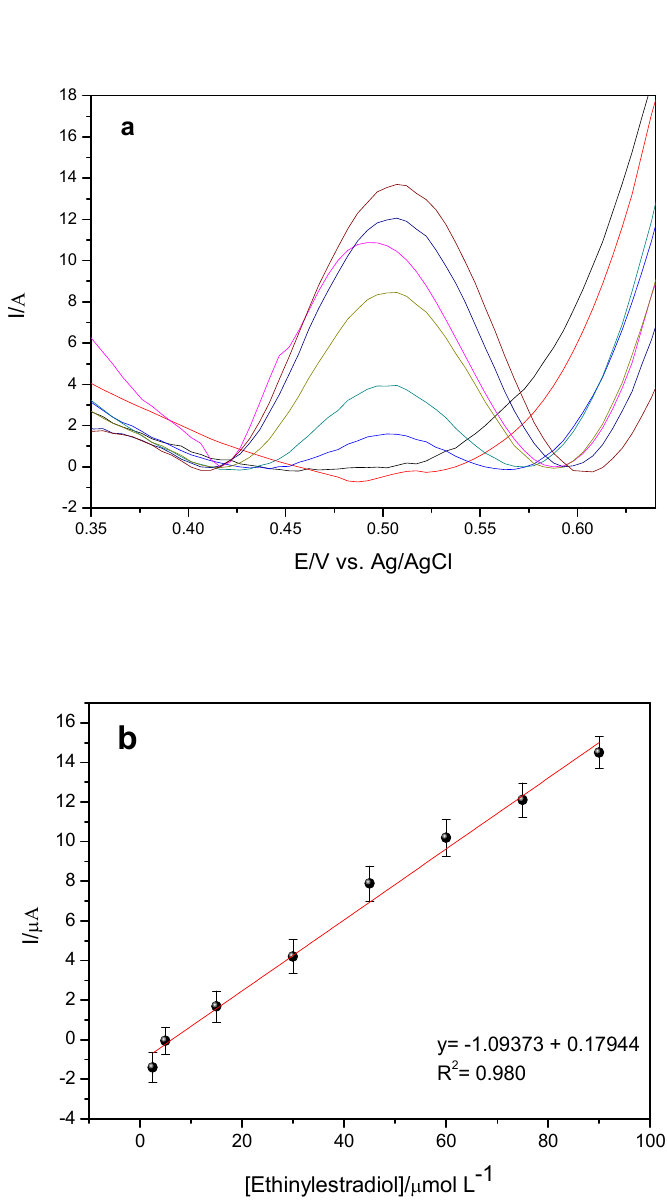
Figure 15. ( a ) Square wave voltammetry. Voltammogram for the determination of EE obtained for successive additions of ethinyl estradiol. Linear range from 2.5 to 90.0 μmol L −1 of ethinyl estradiol. ( b ) Analytical curve constructed from the voltammogram (Figure 15a). Measurements obtained using GCE-MWCNT-CoPc, under optimized experimental conditions, in 0.1 mol L −1 solution of Buffer Phosphate solution pH 7.